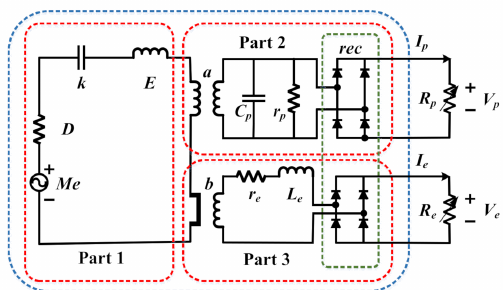
Figure 4. Piezoelectric–electromagnetic coupled equivalent circuit diagram of a single cantilever beam. Part 1 is the mechanical vibration module, part 2 is the piezoelectric module, and part 3 is the electromagnetic module.